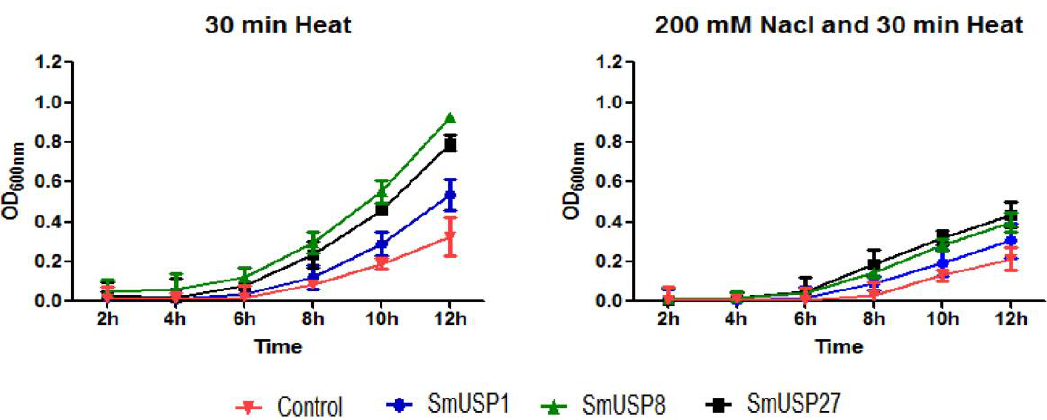
Figure 9. Overexpession of SmUSP1 , 8 , 27 in E. coli enhanced the tolerance to different stresses by liquid assay. Each sample was diluted 200-fold, using fresh LB media, and absorbance (OD 600nm ) was measured for 12 h at 2-h intervals. Each sample has three biological replicates. LB represents samples with the same OD 600 value were inoculated into an LB liquid medium (1:200 ratio); 200 mM NaCl represents those samples were inoculated into an LB liquid medium (1:200 ratio) containing 200 mM NaCl; 30 min Heat represents those samples were exposed to 50 ◦ C for 30 min before being inoculated into an LB liquid medium (1:200 ratio); 200 mM NaCl and 30 min Heat represents those samples were exposed to 50 ◦ C for 30 min before being inoculated into an LB liquid medium (1:200 ratio) containing 200 mM NaCl.